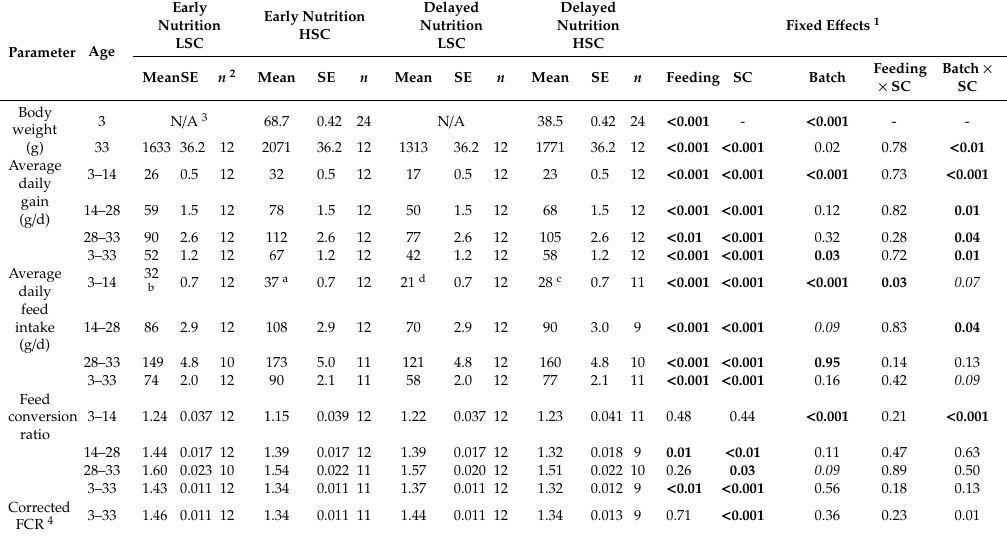
1 Model established p -values for the fixed e ff ect of sanitary condition, feeding, batch, and their two-way interactions. 2 Number of replicate pens, containing 7 (at 3 d of age) or 5 ( > 7 d of age) broilers per pen. 3 Until 3 d of age, all broilers were kept under HSC. 4 Feed conversion ratio standardized to 2000 g of slaughter